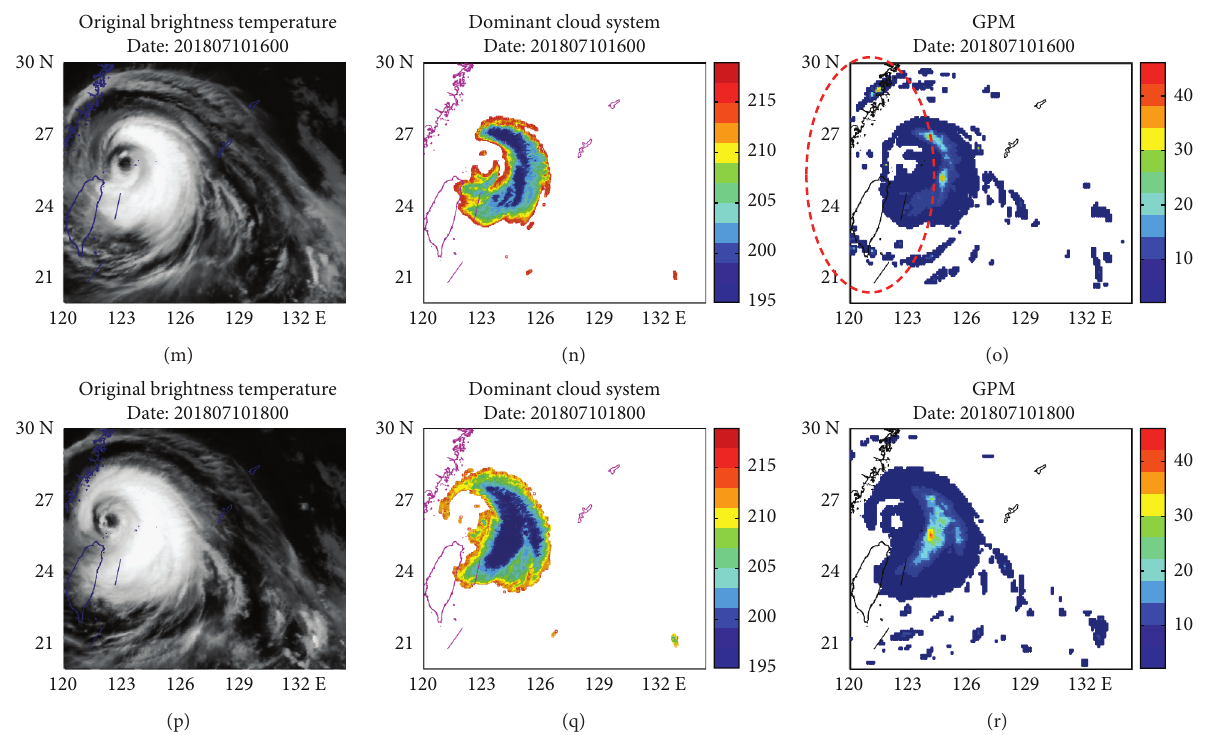
Figure 3: Sequence changes of AGRI original brightness temperature (a, d, g, j, m, p), dominant cloud system based on FCM (b, e, h, k, n, q), and GPM precipitation (c, f, I, l, o,